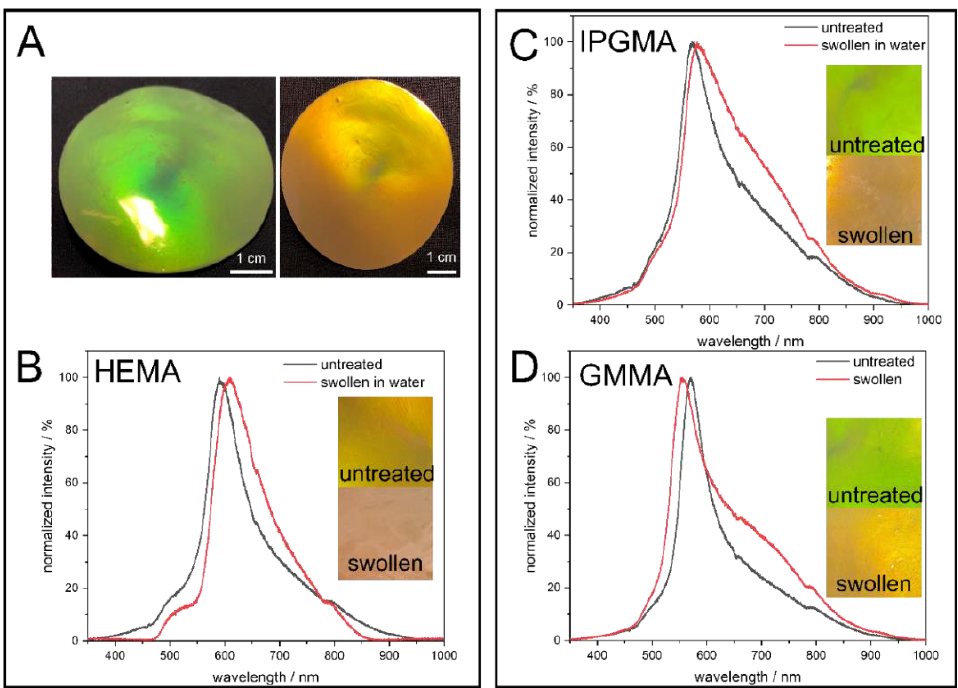
Figure 4. Photographs of ( A ) the PS@P(EA- co -HEMA) opal films under different angles of view, ( B ) as well as before and after swelling in water, and ( C ) the PS@P(EA- co -IPGMA) and ( D ) PS@P(EA- co -GMMA) opal films before and after swelling in water.